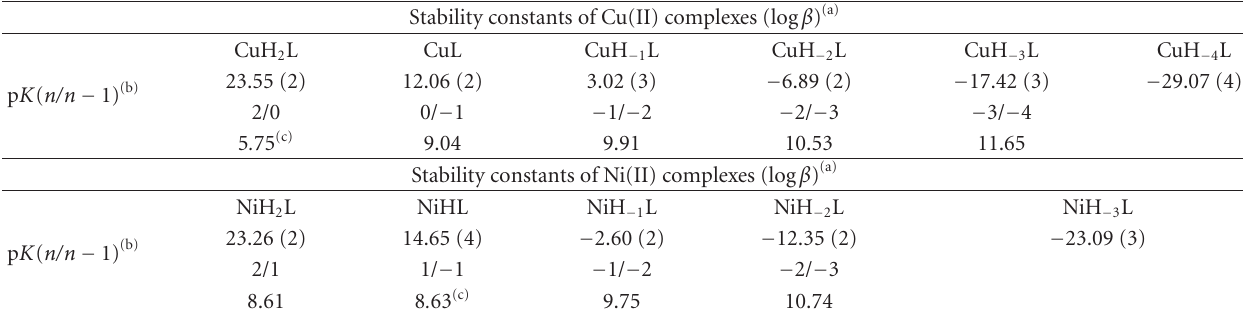
Table 3: Stability constants of Cu(II) and Ni(II) complexes of -LAHYNK- at 25 ◦ C. Stability constants of Cu(II) complexes (log β ) (a)